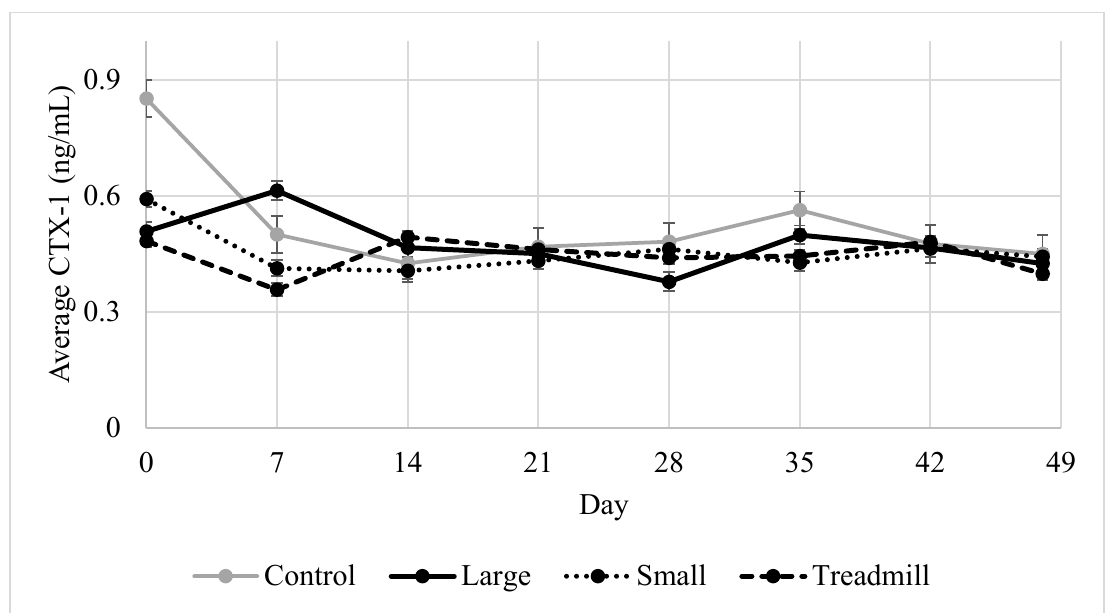
Figure 2. Mean calf serum C-telopeptide crosslaps of type I collagen (CTX-1) by treatment throughout the 7-week study period.